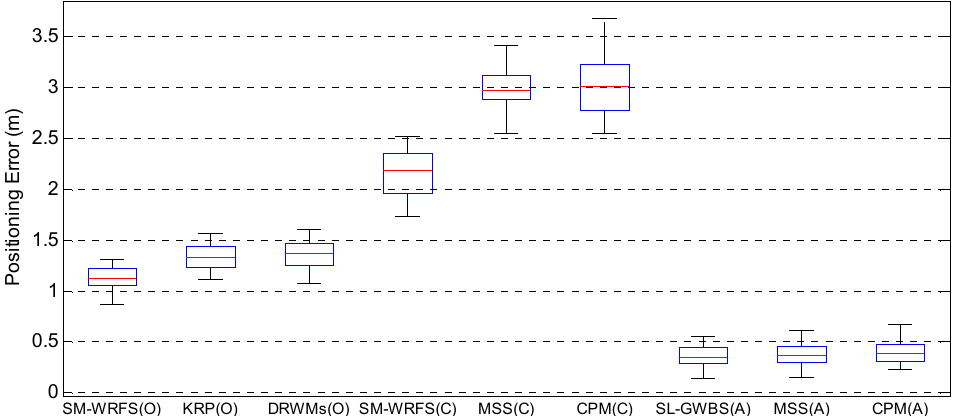
Figure 14. Performance Comparison between State-of-art Algorithms.